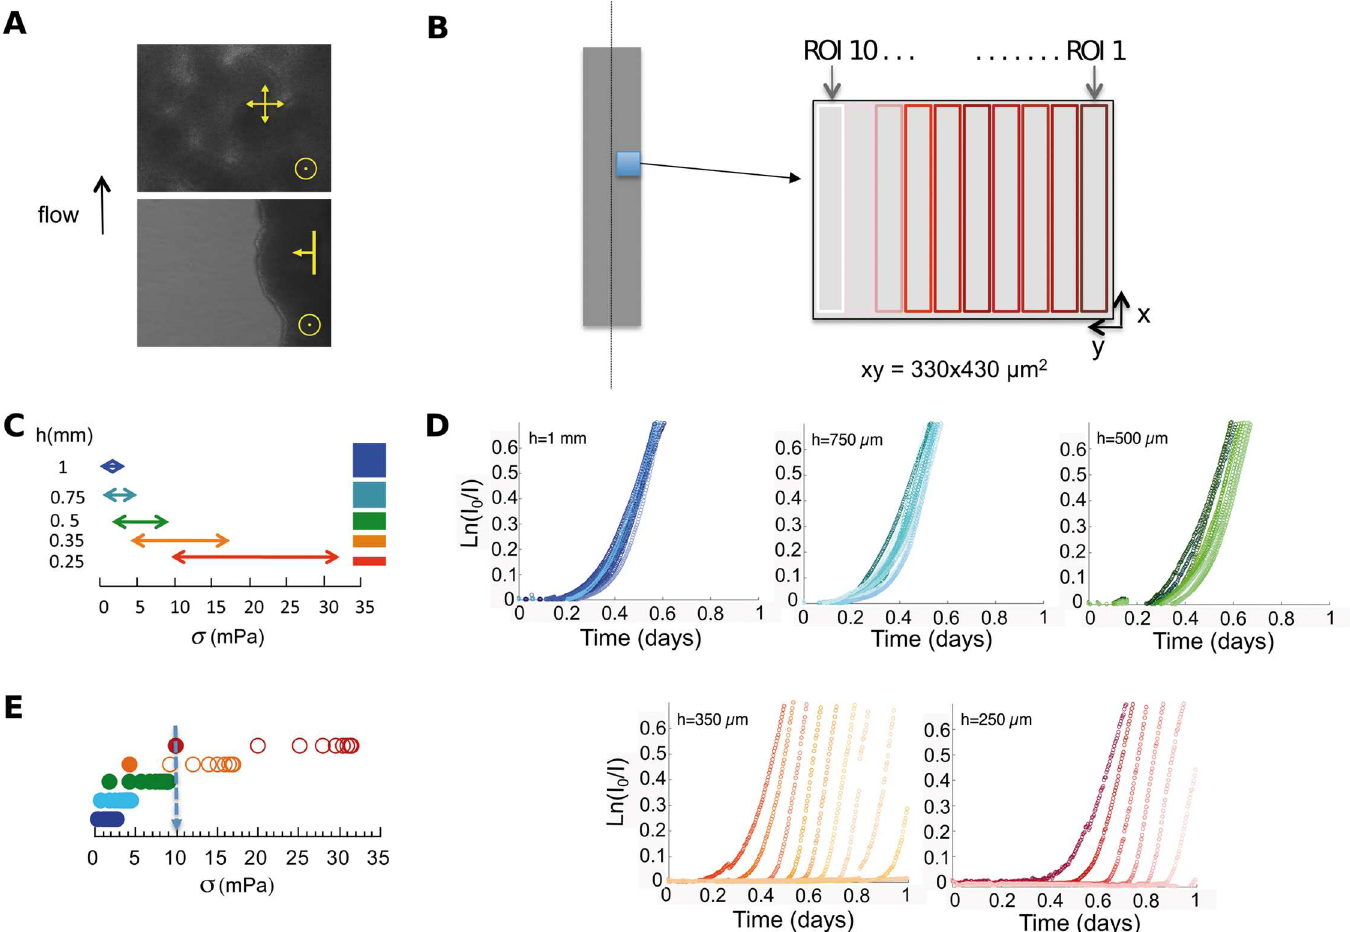
Fig 2. Quantitative monitoring of biofilm growth revealsshear stress impact on biofilm development. (A) Surface pattern of biofilm growingin the uniform growth mode (upper panel)and in the advancing-front growth mode (lower panel), yellow arrows indicate biofilm expansiondirections; bright field picture taken using a 20x objectiveafter 12 hours of continuous growth in M63B1 glucosemedium in a 1 mm-height channel(uniform mode, upper panel)and a 250 μ m-height channel(advancing-front mode, lower panel). The right edgeof the picture coincideswith the right edge of the channel, and a 330x440 μ m 2 field is imaged.(B) Images are dividedin 10 adjacentROIs of 40 μ m width, numbered from 1 (darker shade) to 10 (lighter shade); ROI1 is the channeledge ROI and ROI10 is a central ROI, located at 400 μ m from the channeledge. (C) Bottom shear stress ranges overlappingbetweenthe 5 channels of the setup with channelheightson the left and aspect ratios on the right. Same channelcolor code as in Fig 1. (D) Series of growth curves derivedfrom time-lapseimage analysis. The microscopicabsorbance, A μ = ln( I 0 / I ), reportingthe local biomass, is plotted as a function of time under continuousnutrient flow. Data points are representedin color for 10 ROIs per channel(one channelper graph) using the same color code as in Fig 1, and shades from dark to light codingfor ROI1 to ROI10. Plot of a representative experiment of at least three (see data statistical dispersion in S1 Table). (E) Biofilm initiationis subjectedto a 10 mPa shear stress threshold. ColonizedROIs (closed symbols) and non-colonizedones (open symbols), as observed in the 5 channels(same color code as in Fig 1) duringthe initial phaseof biofilm development, are orderedon a shear stress range, evidencing the 10 mPa transition (arrow) betweena shear stress which permits initial adhesionand a shear stress which does not.